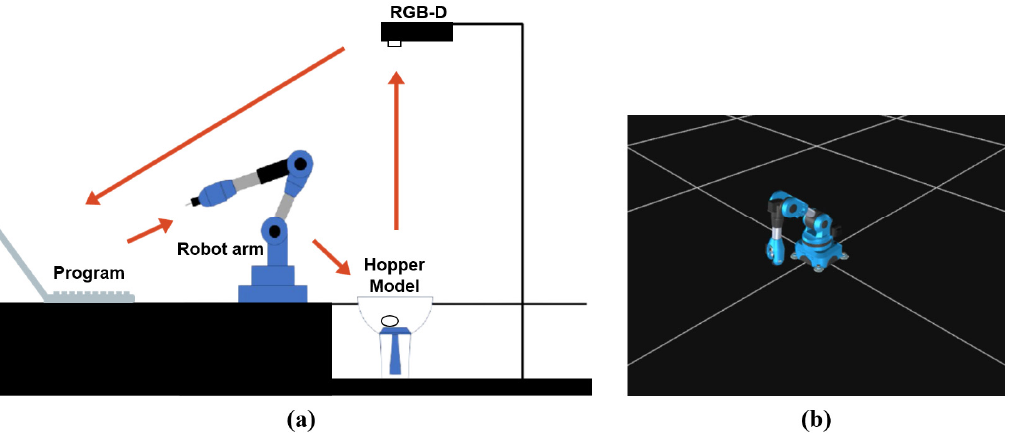
Figure 2. Overall structure of the proposed smart hopper system ( a ) and simulation of the robot arm in virtual space ( b ).